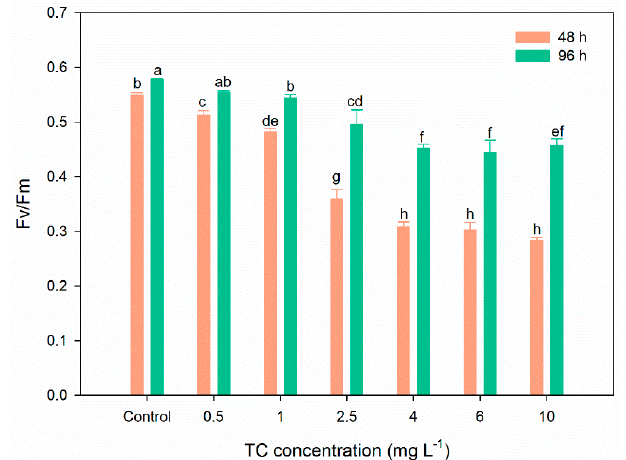
Figure 3. Effects of TC on the Fv/Fm of C. pyrenoidosa after 48 and 96 h of exposure in different treatments. The different letters indicate significant differences ( p < 0.05) between the control and experimental treatments.